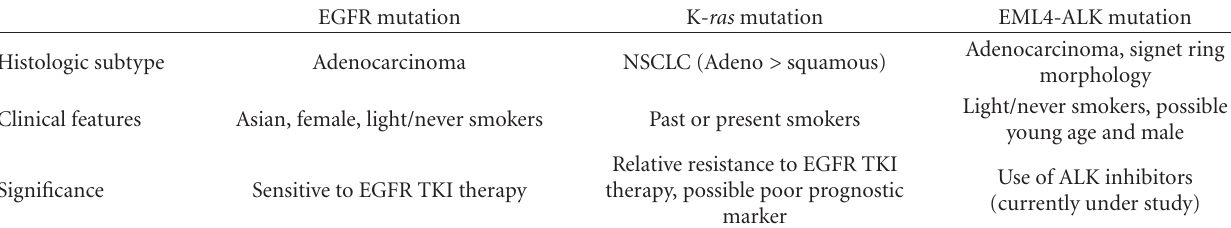
Table 3: Clinically relevant molecular and clinicopathologic features of